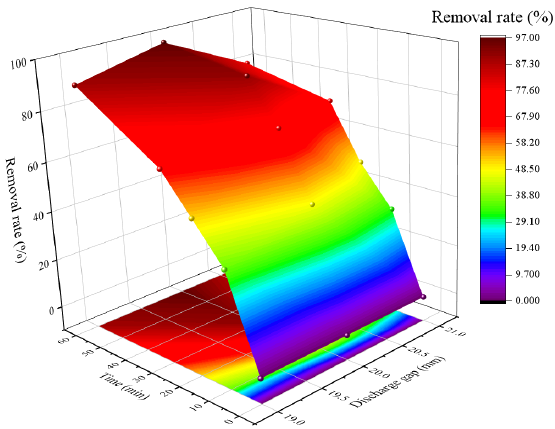
Figure 3. The influence of discharge gap on removal rate of MO.